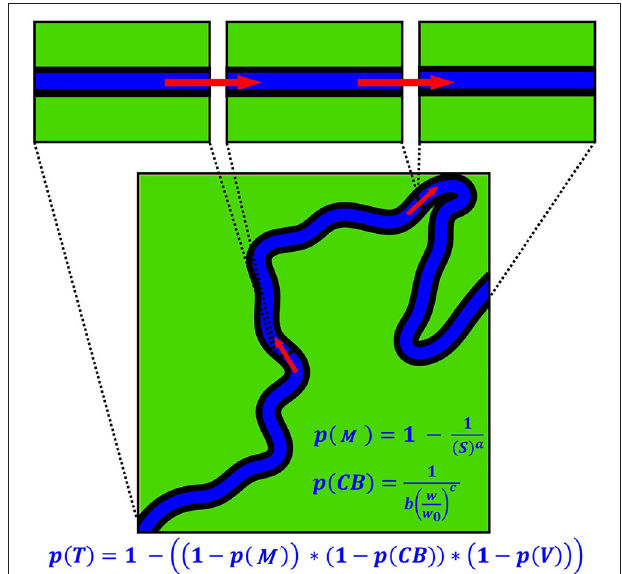
FIGURE 2 | Schematic illustration of the transfer of macroplastic debris downstream from cell to cell. Also shown are the equations used to calculate the combined probability of trapping, p ( T ), probability of trapping along meander bends, p ( M ), and probability of trapping along channel banks, p ( CB ).